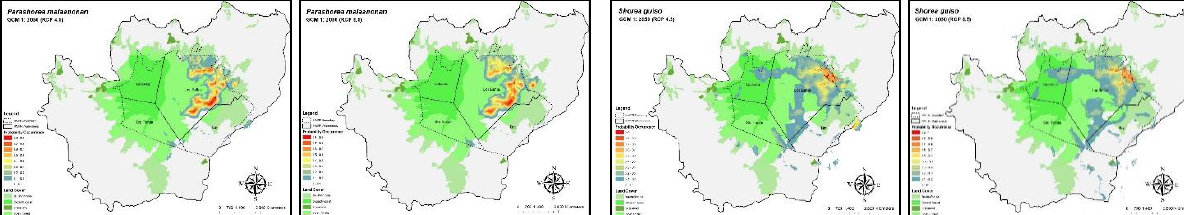
Figure 5. Current distribution of Parashorea malaanonan (L) and Shorea guiso (R) in MMFR.